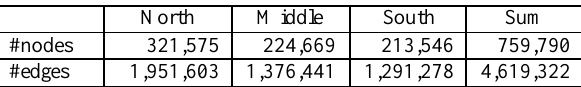
Table 3: Number of nodes and edges of 3 test parts in Bonnland .